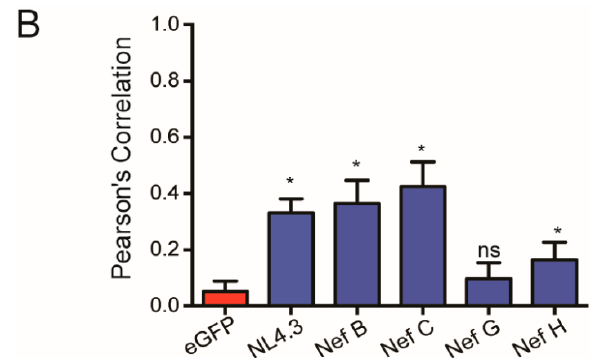
Figure 6. Nef from reference strains of HIV-1 group-M subtypes display differential levels of colocalization with CD63. ( A ) CD4 HeLa cells were transfected with various Nef–eGFP fusion plasmids encoding Nef from different HIV-1 subtype reference strains. Cells were fixed in 4% paraformaldehyde, immunostained for CD63, and imaged on a Leica DMI6000 widefield microscope on the 100 × objective; scale bar = 10 µ m, green = Nef–eGFP, red = CD63. ( B ) Images were deconvolved, and colocalization analysis was completed using the Pearson’s Correlation with the Image J JaCoP plugin. Mean (+/ − SD) Pearson’s correlations of Nef and CD63 colocalization are illustrated from three independent experiments. Red bar = negative control. (ns: non-significant; * p ≤ 0.05; SD: standard deviation).